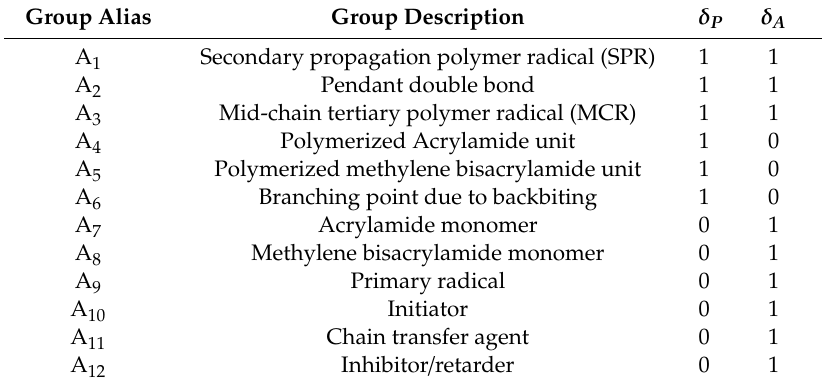
Table 2. Set of chemical groups considered in the kinetic modeling of the crosslinking polymerization of acrylamide (AAm) with methylene bisacrylamide (MBAm).